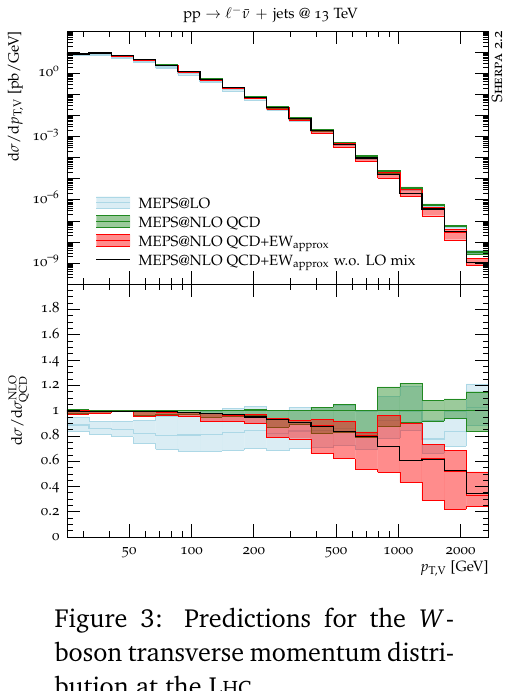
Figure 3: Predictions for the W - boson transverse momentum distri- bution at the L HC .